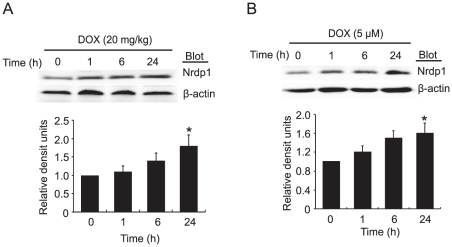
DOX stimulates Nrdp1 protein expression.Time-course of the protein expression of Nrdp1 in mouse hearts (n = 3) after intraperitoneal (ip) injection of 20 mg/kg DOX (A) or in neonatal rat cardiomyocytes after 0.5 µM DOX treatment (B). β-actin was used as a loading control. Quantitative analysis is in bottom panels (n = 3 experiments for each time points). *P<0.05 vs 0 hour.